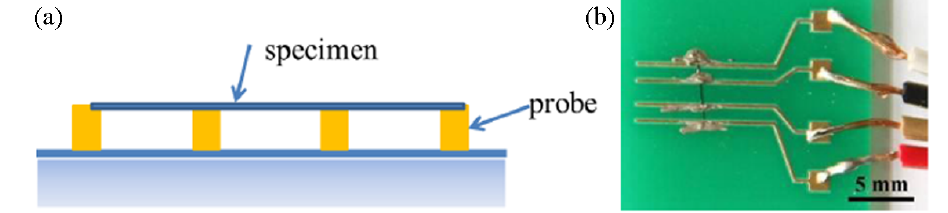
Figure 6. ( a ) Schematic illustration of the four-probe configuration for measuring the specific heat and thermal conductivity of a filament-like specimen; and ( b ) The four-probe configuration on the specimen holder for measuring the in-plane thermal conductivity of the film. Reproduced from [62] with permission; Copyright John Wiley & Sons, Inc. 2016.